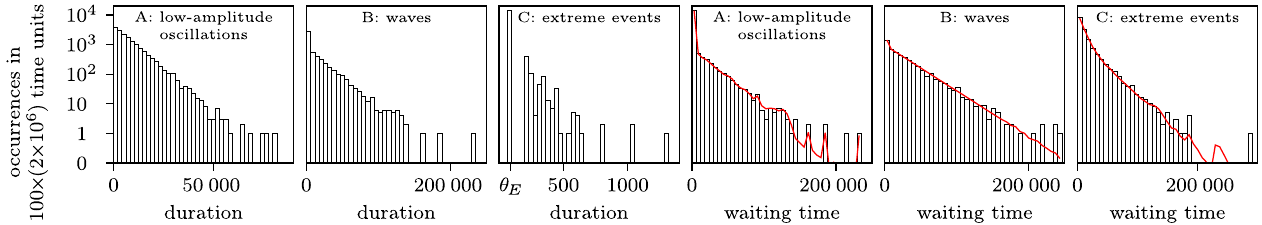
FIG. 4. Black: Histograms of pattern durations and waiting times (end to beginning) between subsequent occurrences of one pattern in 100 × ð 2 × 10 6 Þ time units. For the former, only patterns that begin and end during the observation time are taken into account. Red: The same averaged over 200 simulations of the pattern sequences (of the same length as the originally observed pattern sequences) as second-order Markov chains with durations of patterns randomly assigned from the respective distributions shown in the left half. Occurrences of pattern C that are longer than θ E ¼ 90 are due to a few events occurring in short succession. They contain at most six events and make up for less than 5 % of all occurrences of pattern C.